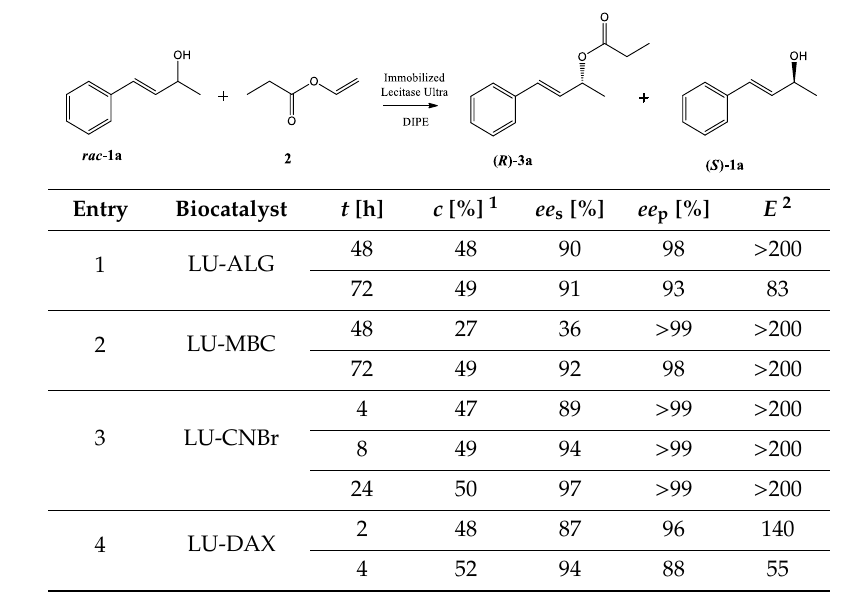
Table 1. Transesterification of racemic ( E ) ‐ 4 ‐ phenylbut ‐ 3 ‐ en ‐ 2 ‐ ol ( 1a ) catalyzed by Lecitase™ Ultra immobilized on various supports.